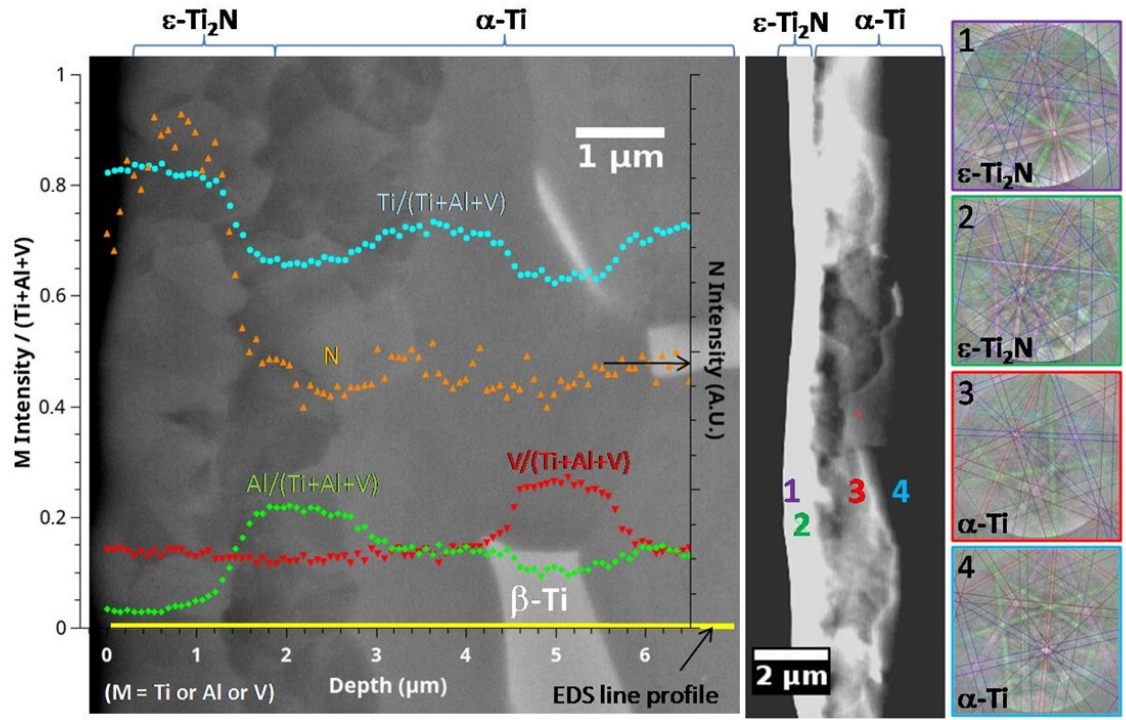
Figure 2. SEM, EDS and EBSD results obtained on cross section of Ti-6Al-4V sample treated via PBII (25 kV, 200 Hz, 10 µs) for 240 min at 800 °C in a mixture of 90% N 2 –10% H 2 at 1 Pa.